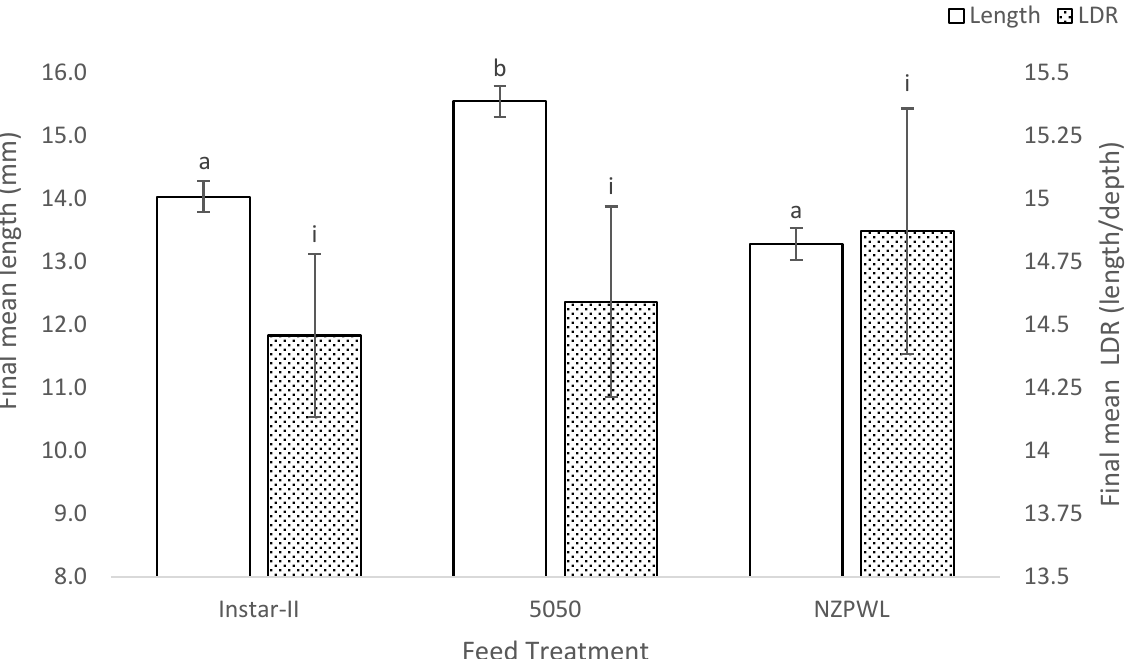
Figure 2. Final mean total length (primary axis) and mean length:depth ratio (secondary axis) of larval giant k ō kopu for three different feed treatments, Instar-II+, 5050, and NZPWL, at the end of the 28-day experimental period (mean ± SE). Means with different superscripts are significantly different among either final mean total length or mean length:depth ratio ( p < 0.05).